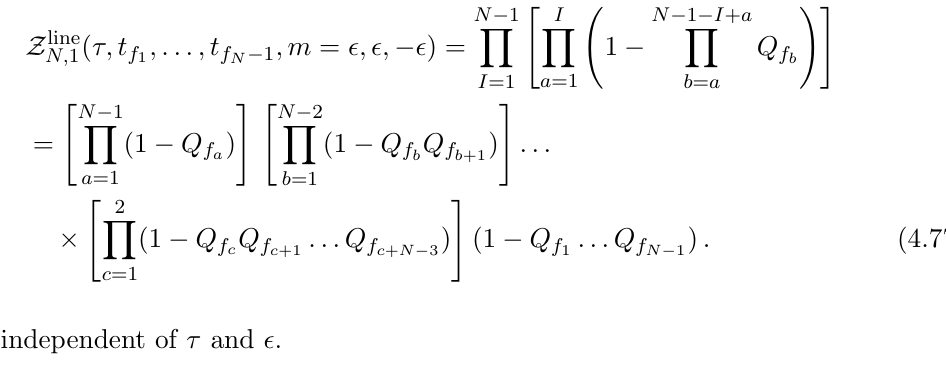
with the simple weights L 1 (red), L 2 (blue), L 3 (green) and L 4